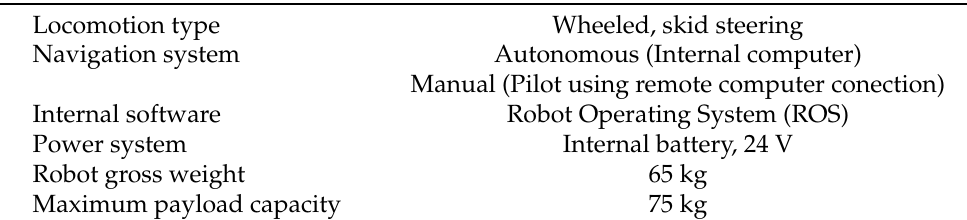
Figure 7. View of the robot during inspection. Table 1. Inspection robot main